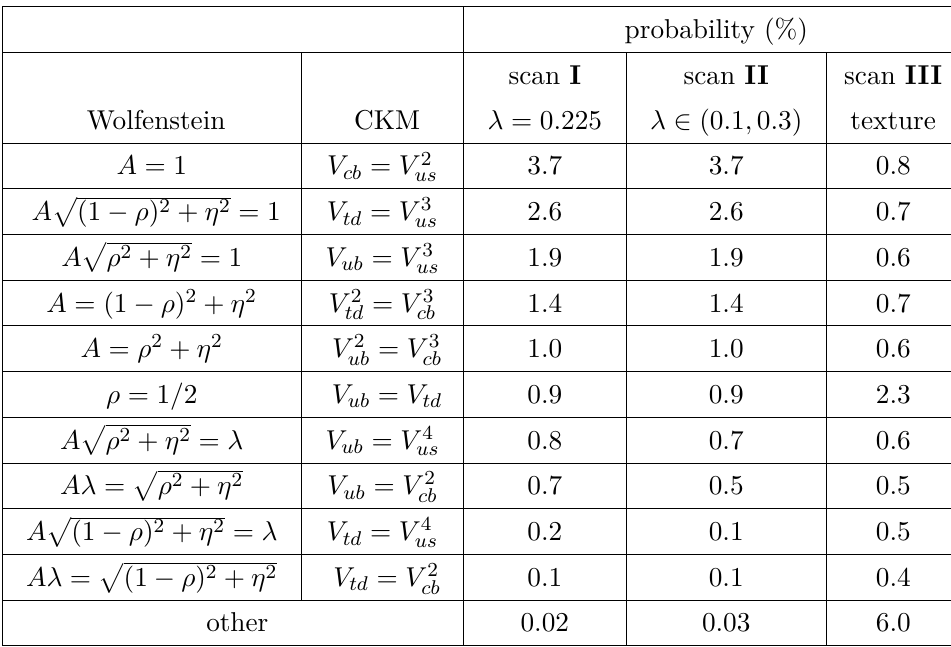
Table 1 . We generated 10 6 random CKM matrices using the prescriptions of scans I , II , and III , described by eqs. (3.1), (3.2), and (3.6). We find that 13%, 13%, and 14%, respectively, satisfy at least one simple relation, as in eq. (3.3), with precision δ = 0 . 02 . We show the 10 most common relations for scan I . The first column shows each relation as a function of Wolfenstein parameters, and the second column is an example of how the relation manifests as a function of CKM matrix elements. The final three columns show the probability that a random CKM matrix, from each scan, satisfies the relation with precision δ = 0 . 02 . The last row shows the probability of satisfying additional relations not listed in this